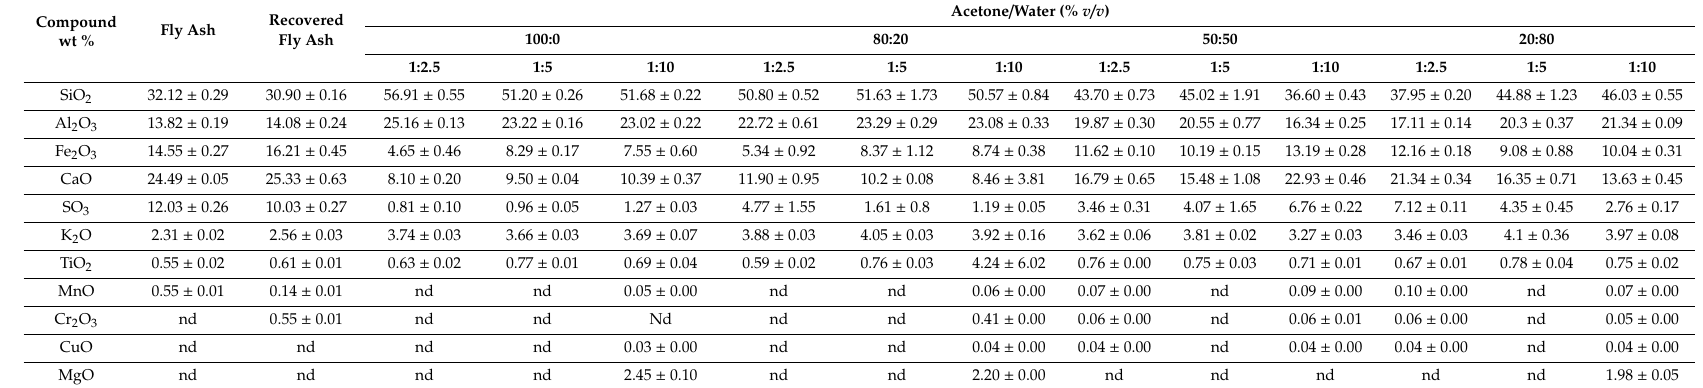
Table 3. Chemical compositions of fly ash, recovered fly ash, and cenospheres collected from using di ff erent ratios of freshly prepared acetone–water mixtures, a 4-h soaking period, and fly ash / medium ratios of 1:2.5, 1:5, and 1:10 (nd is not detectable by the instrument). All data points were obtained from three